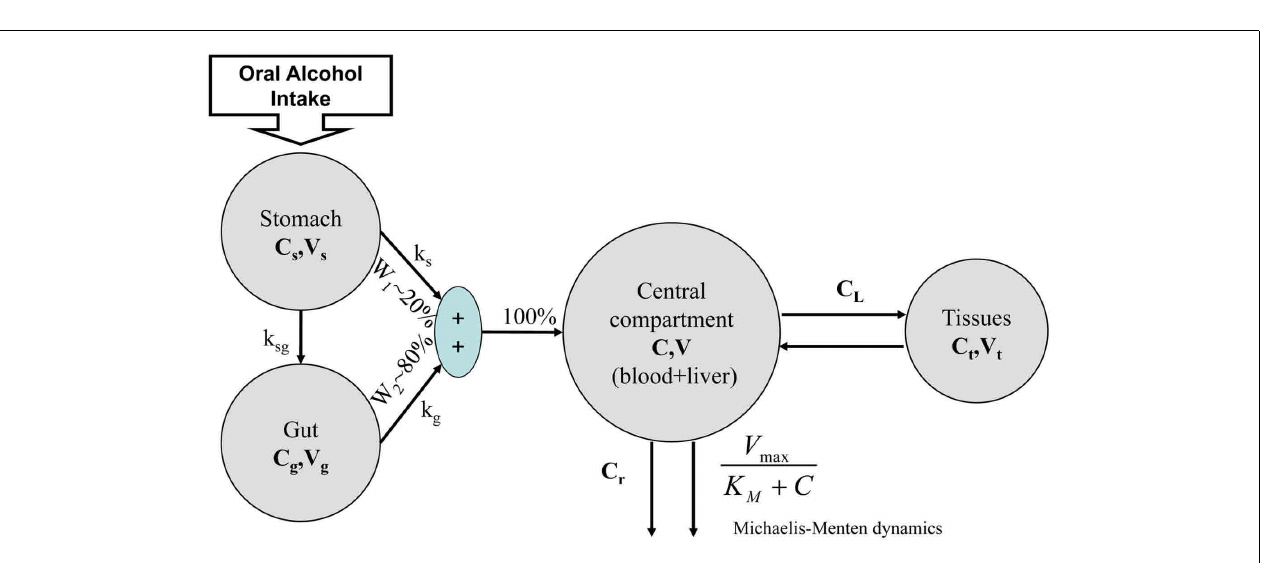
proportion of gastric diffusion from the stomach, W s , vs. diffu- sion from the gut, W g (e.g., W s = 20 vs. W g = 80%; Norberg et al.,